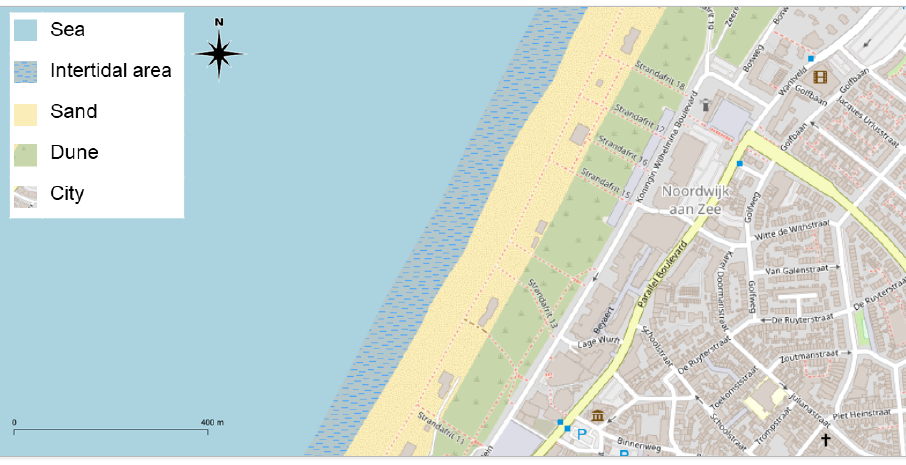
Figure 1. Units map of the study area, partial view (background image from